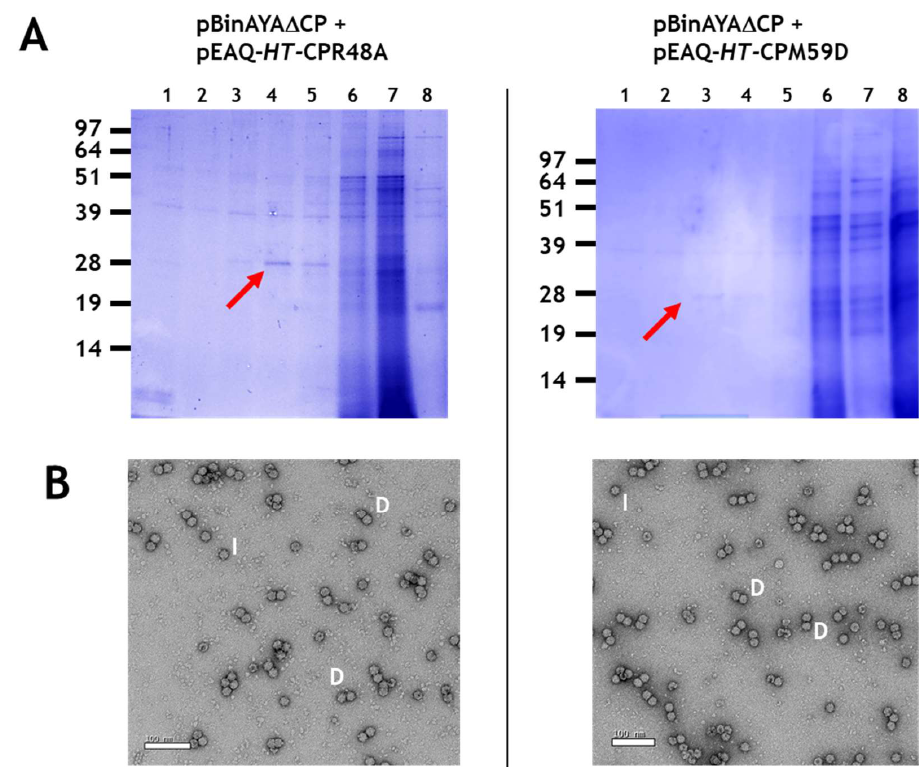
Figure 4. ( A ), Caesium sulphate gradient profile of protein resolved in 12% MOPS buffered NuPAGE following the co-infiltration of pBinAYA ∆ CP with either pEAQ- HT CPR48A or with pEAQ- HT CPM59D. Red arrows indicate caesium sulphate fractions that contain coat protein. ( B ), Transmission electron microscopy of caesium sulphate fractions that contain coat protein. I, isometric; D, double morphological particles.